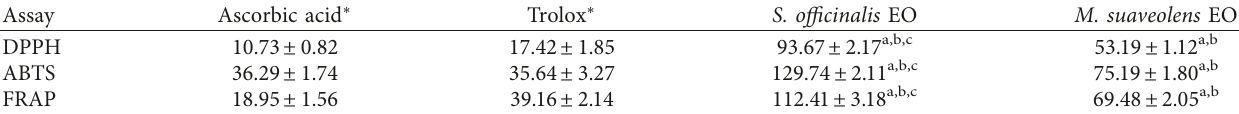
Table 1: antioxidant activity of the essential oils (EOs) of Salvia officinalis and Mentha suaveolens . Assay Ascorbic acid